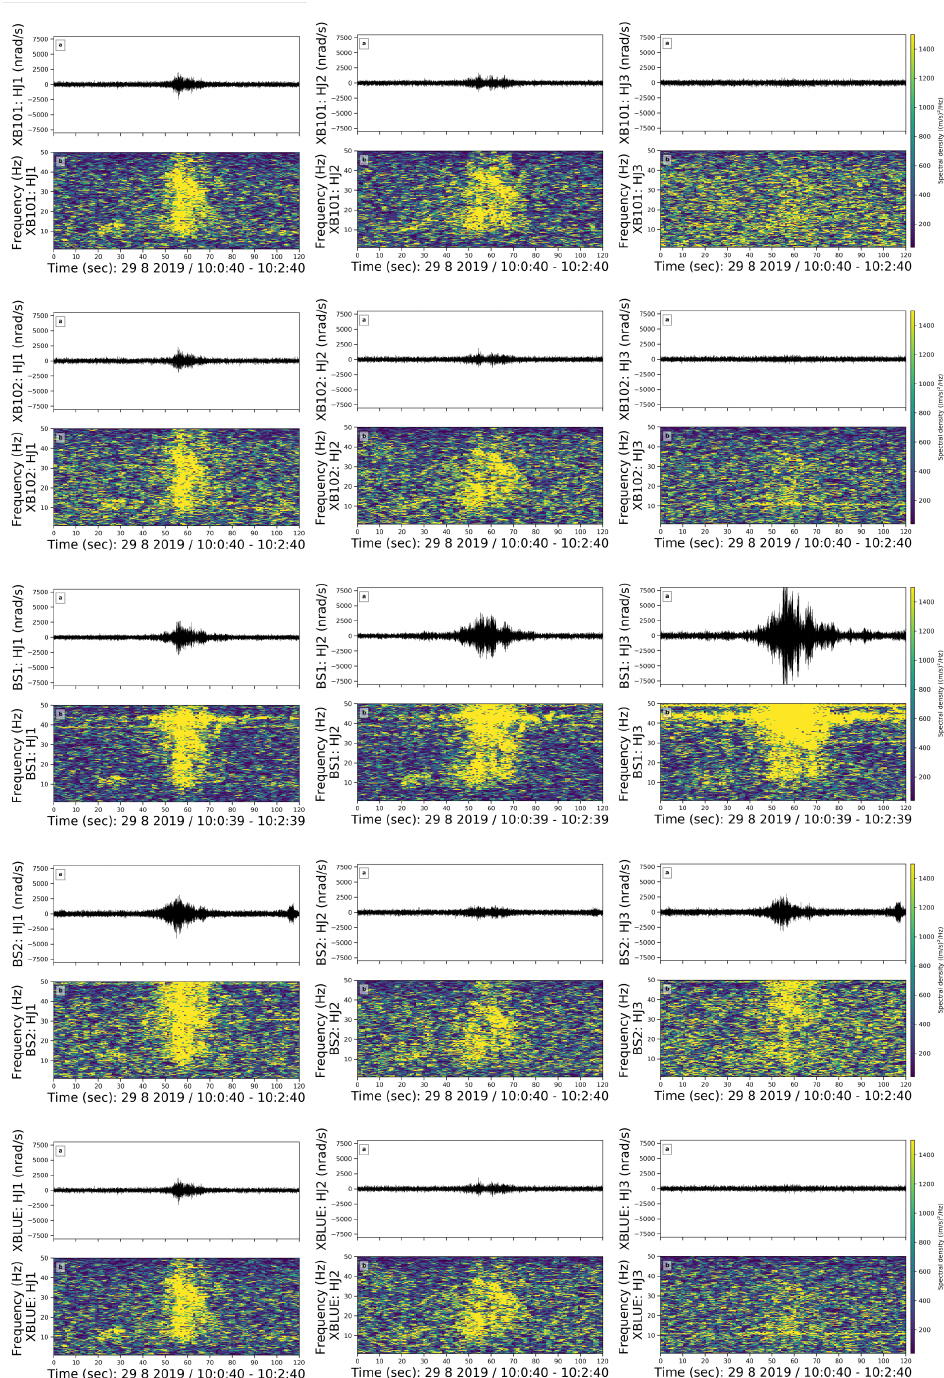
Figure 7. Emergent burst-like noise in a 2 min long time window on doy 241, i.e., 29 August, Thursday. The subfigure structure, content and colors are the same as in Figure